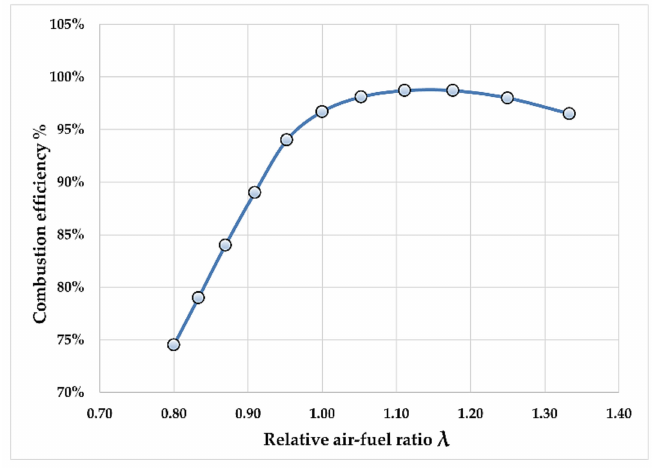
Figure 7. Spark ignition engines combustion efficiency as function of the relative air-fuel ratio λ .